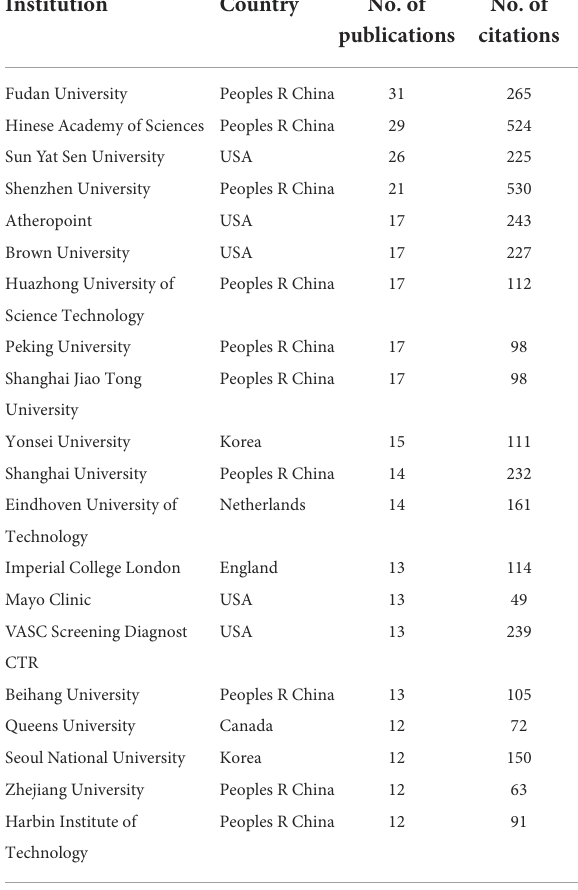
TABLE 2 Top 20 institutions with most numbers of publications related to the use of AI in ultrasound. Institution Country